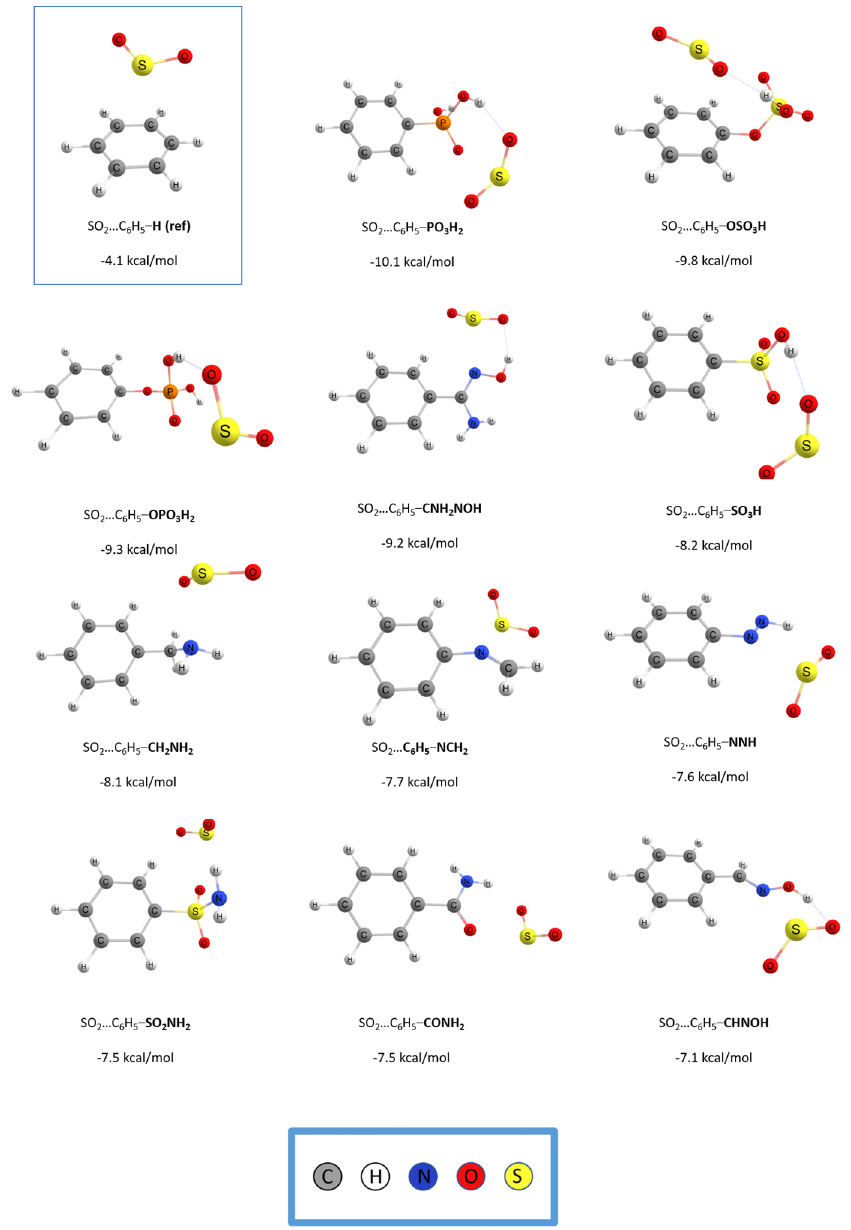
Figure 1. The optimized geometries for the 11 best performing functionalized benzene and the unfunctionalized for comparison, along with the corresponding binding energies calculated at the DSD–BLYP/def2–TZVPP level of theory, corrected for BSSE.